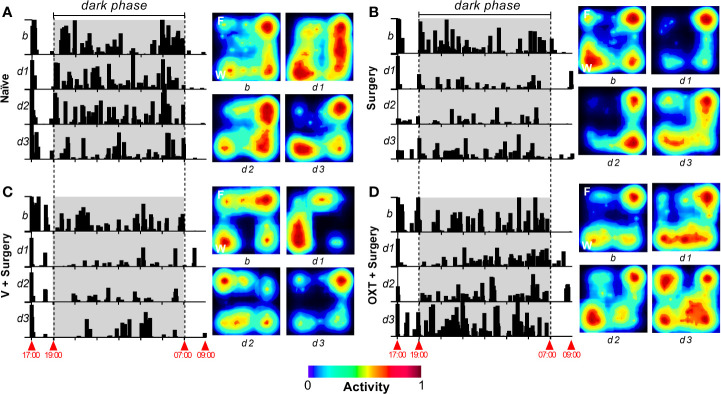
Appearance of ambulatory activity and representative heat maps of different treatments before and after the surgical procedure. In all panels, to the left, a raster plot of the ambulatory activity is shown; the data was obtained through a 16-h recording between 17:00–09:00 h for 4 days, where b represents the basal value, and d1, d2, and d3 represent day 1, day 2, and day 3, respectively, after the incision of the hind paw. To the right of each panel, a representative heat map of horizontal locomotor activity is depicted, where F and W represent the site in the open-field system where the food and water were presented. In the case of naïve animals (A), the actograms and heat map are similar across test days; note that, according to the heat maps, naïve animals move around the open-field system in a similar pattern across all test days. Comparable results were obtained in basal condition in all animal groups. When the animals were subjected to an incision of the hind paw [(B–D)], activity was clearly impaired at d1. Furthermore, at d3 the spontaneous activity was partially recovered (compared to basal condition) in the Surgery and Vehicle + Surgery groups. In the case of animals pretreated with 10 nmol oxytocin (OXT) (D), a minimal impact in the activity was recorded at d1, and a complete recovery in the activity was achieved at d3.